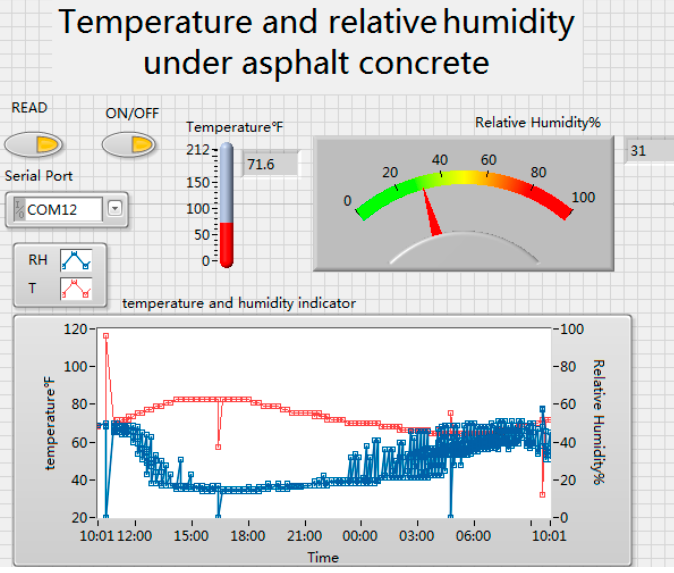
Figure 24. Asphalt temperature and humidity of the host computer.